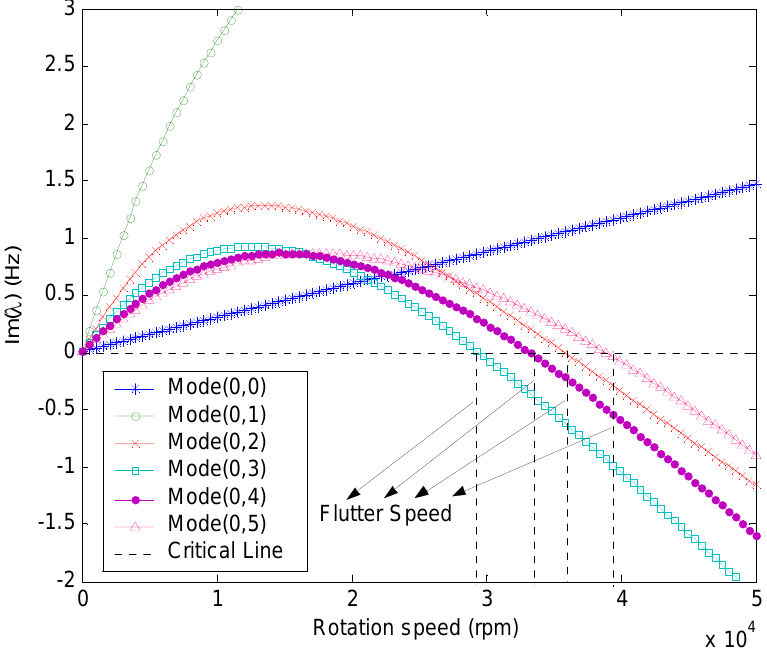
Figure 7. Imaginary part of the eigenvalues versus rotational speed for modes (0,0)~(0,5) of the disk in the enclosure with